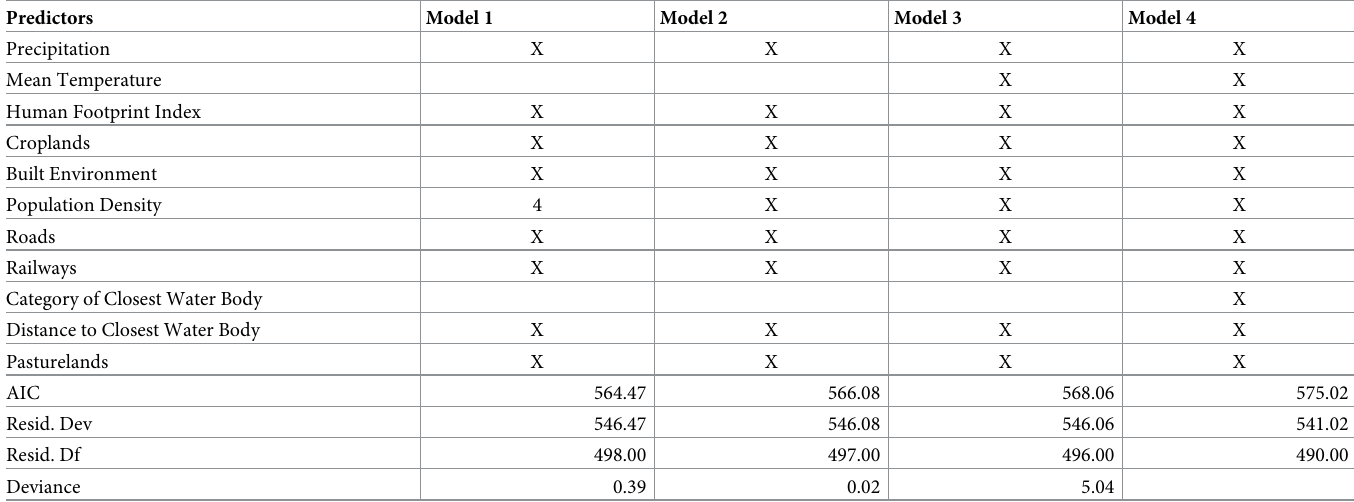
Table 4. Selection for the lowest AIC model for